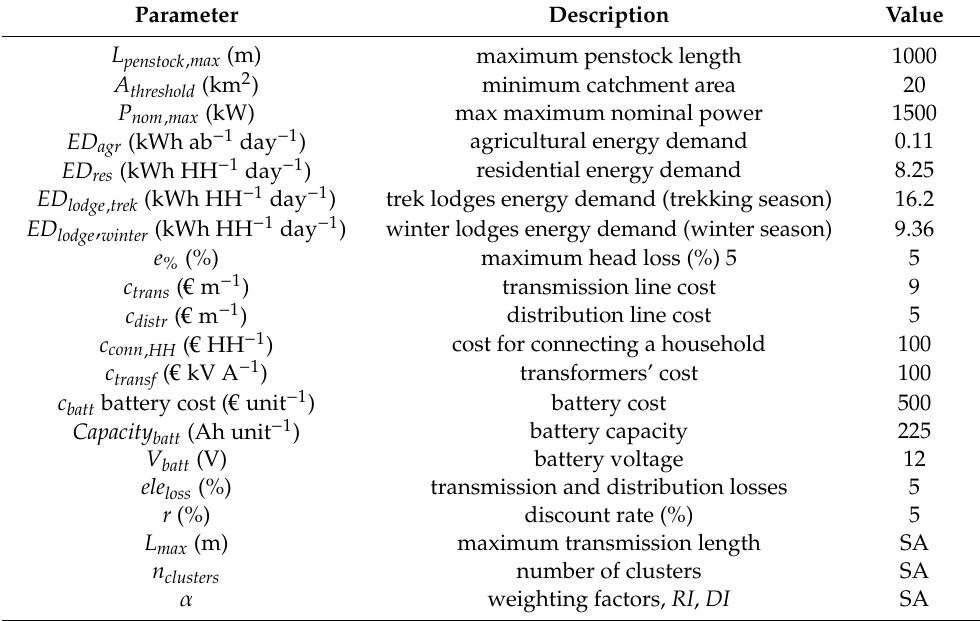
Table 4. Hydroelectric input parameters for Poli-ROR , and values assigned. SA means that a sensitivity analysis was carried out to assign a best value, see Section